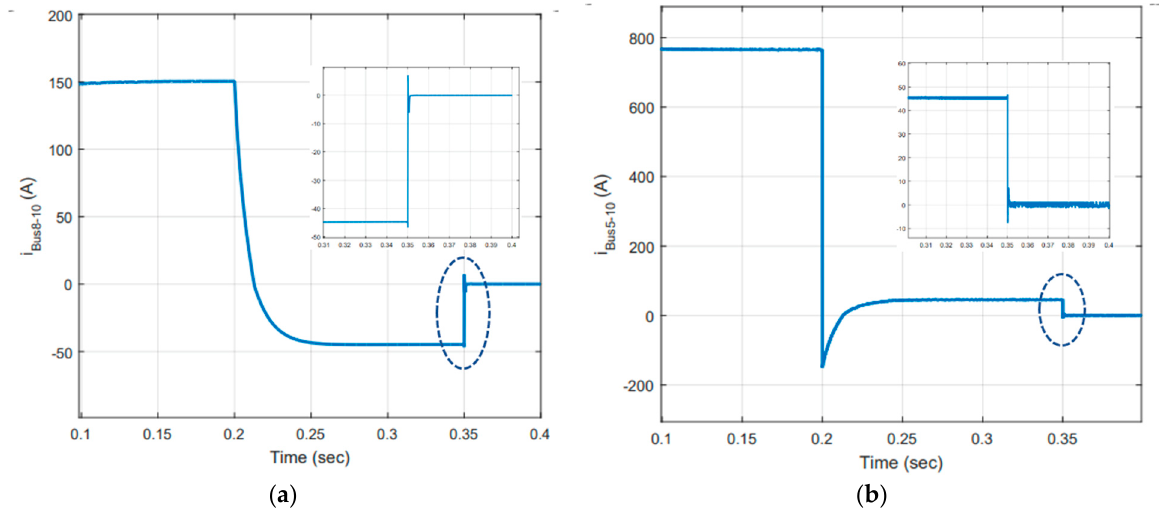
Figure 14. Current waveforms during fault occurring in the middle of the line between bus 8 and bus 10: ( a ) Bus 8-bus 10 and ( b ) Bus 5-bus 10.